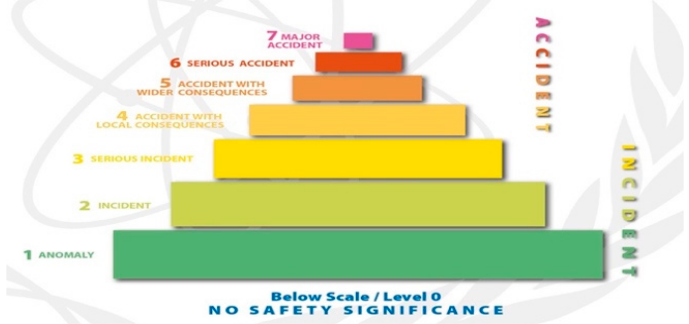
Figure 1. International Nuclear and Radiological Event (INES) Scale. Source: International Atomic Energy Agency official website—https://www-news.iaea.org/InesScale.aspx (accessed on 5 May 2022).